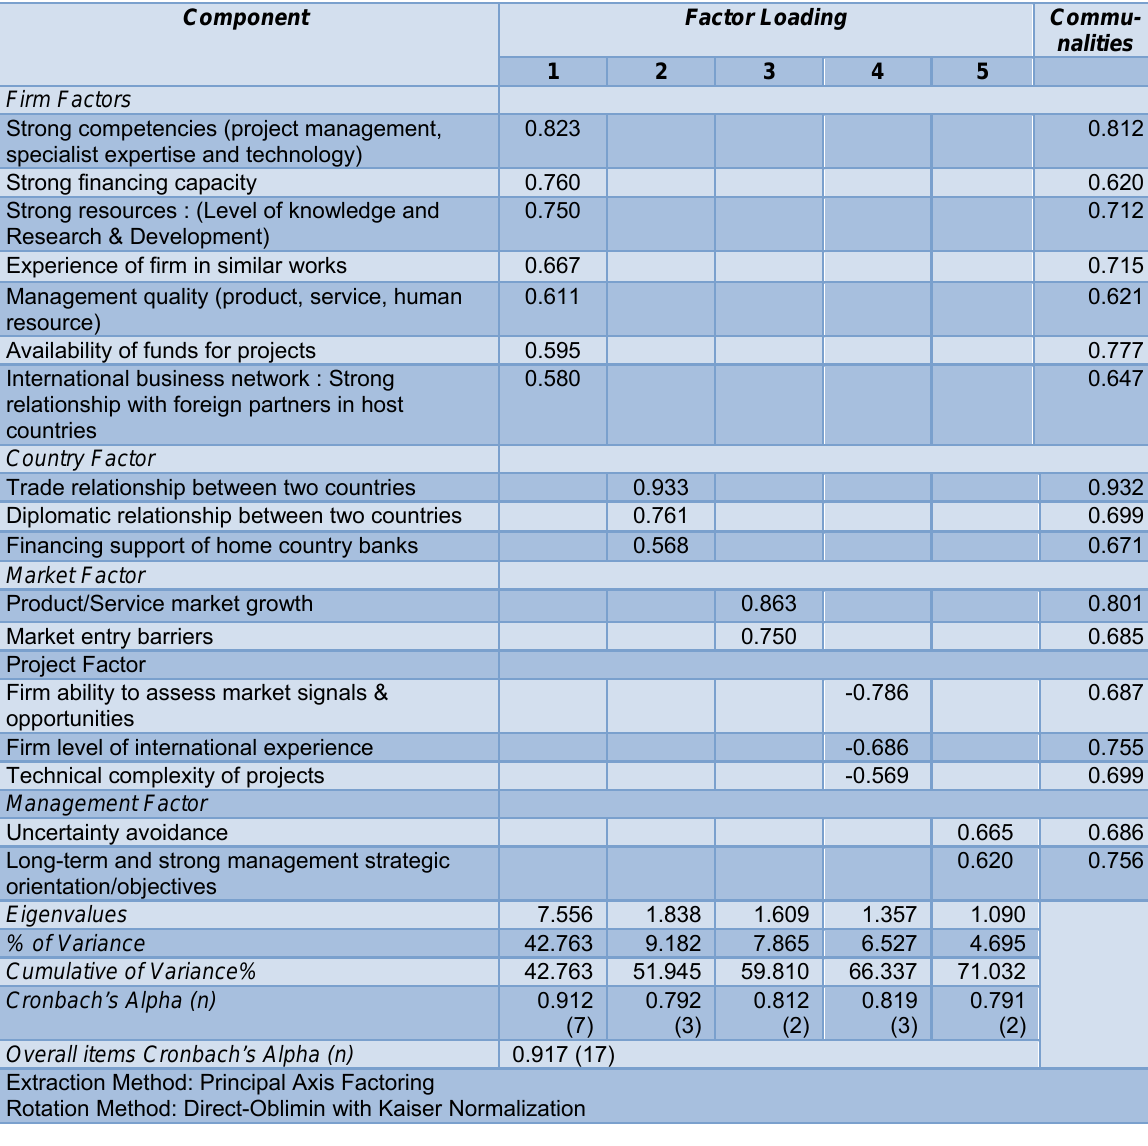
Table 4: Factor loadings using Principal Axis Factoring (PAF) for EL Decision Component Factor Loading